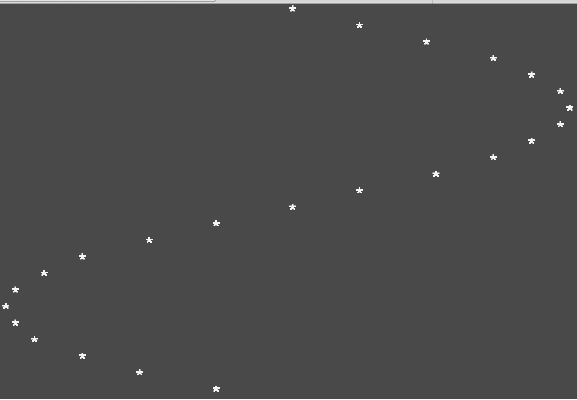
Figure 3. CS1: First “graphics” encounter, character-plot sine